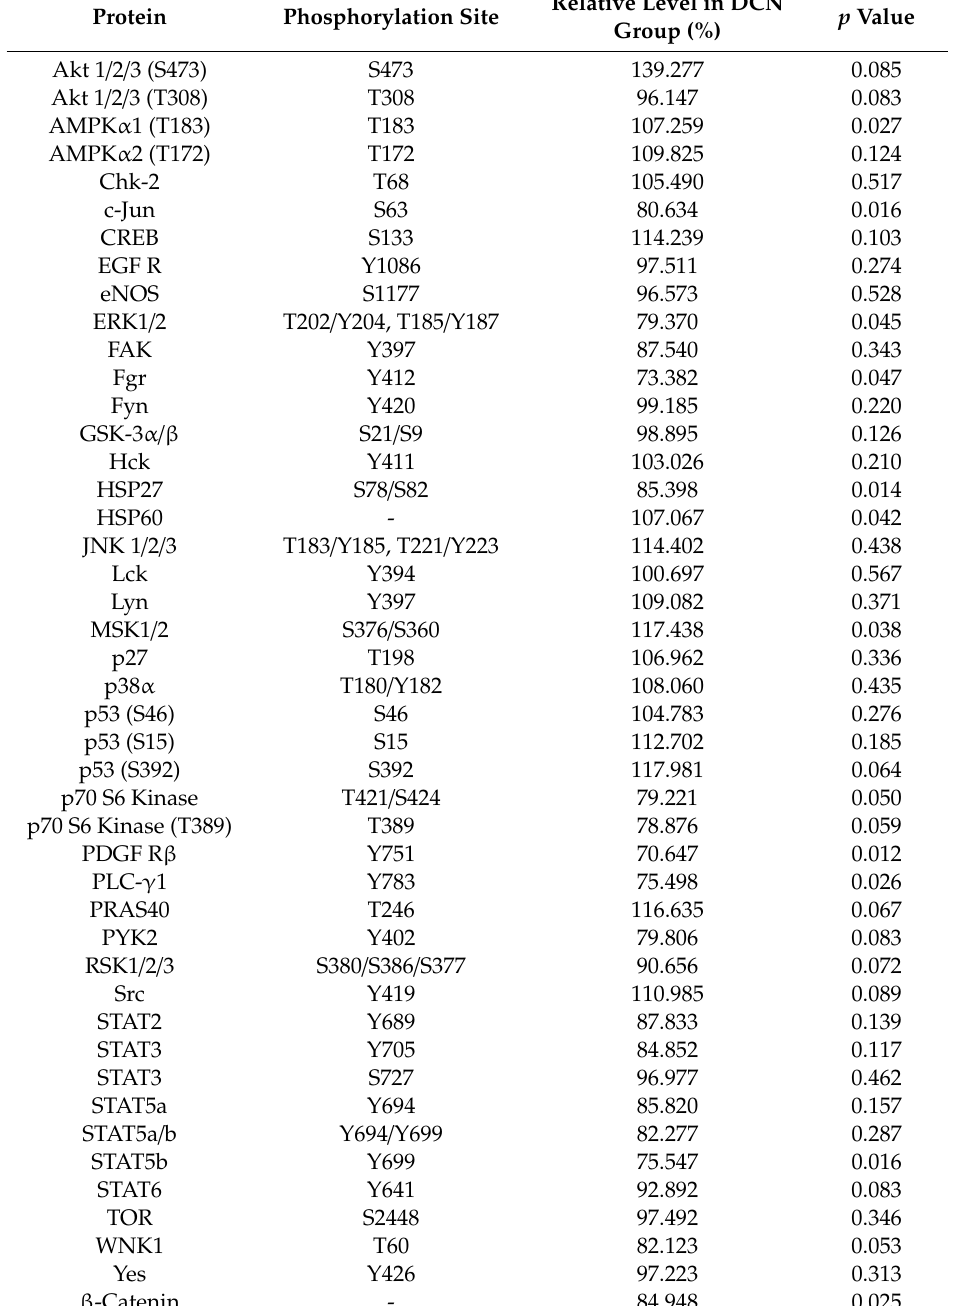
Table 1. Changes in signaling proteins detected by phosphokinase array. The table shows the relative protein levels in decorin-transfected (DCN) versus null-vector-transfected mice inoculated with c38 colorectal cancer cells. Data represent the mean of two independent